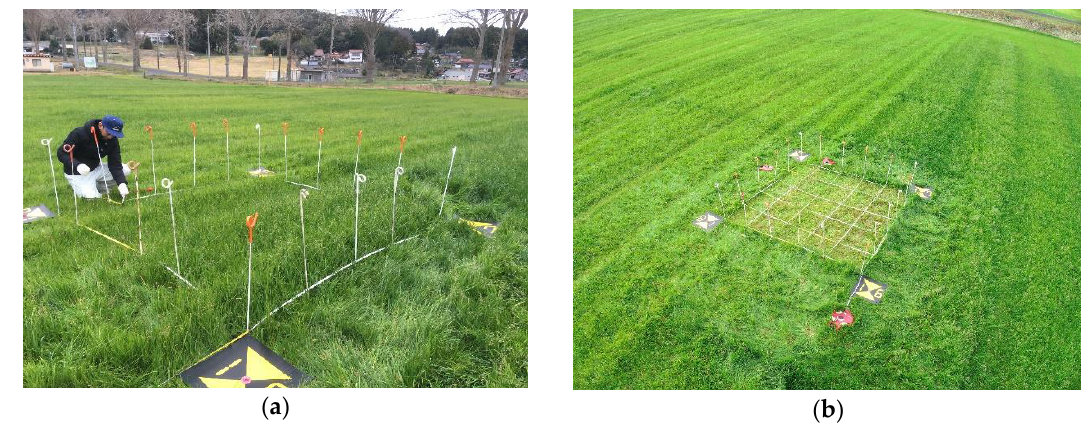
Figure 1. Study site: Italian ryegrass ( Lolium multiflorum Lam.) grassland ( a ) before harvesting and ( b ) after harvesting.